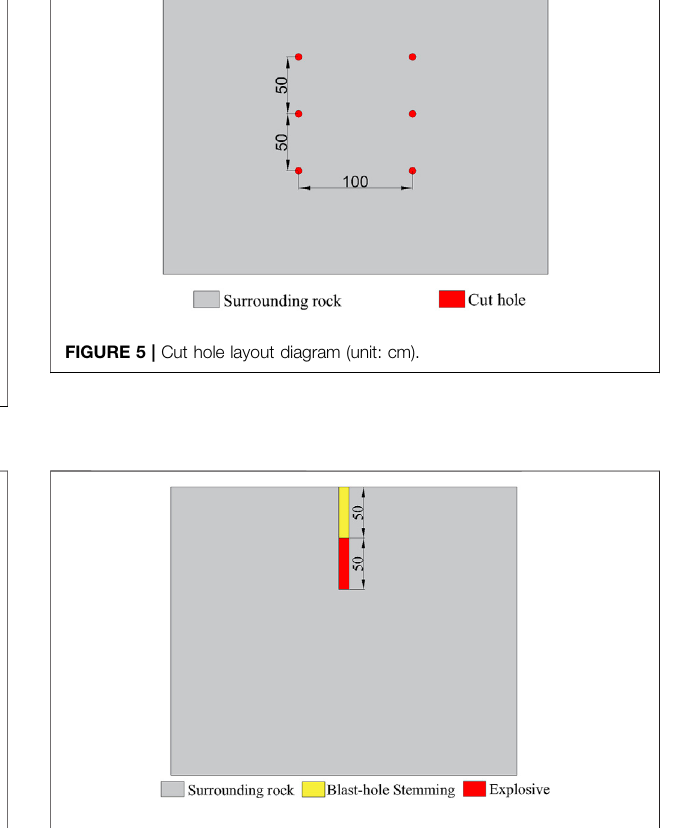
FIGURE 6 | Blasting hole coupling indication (unit: